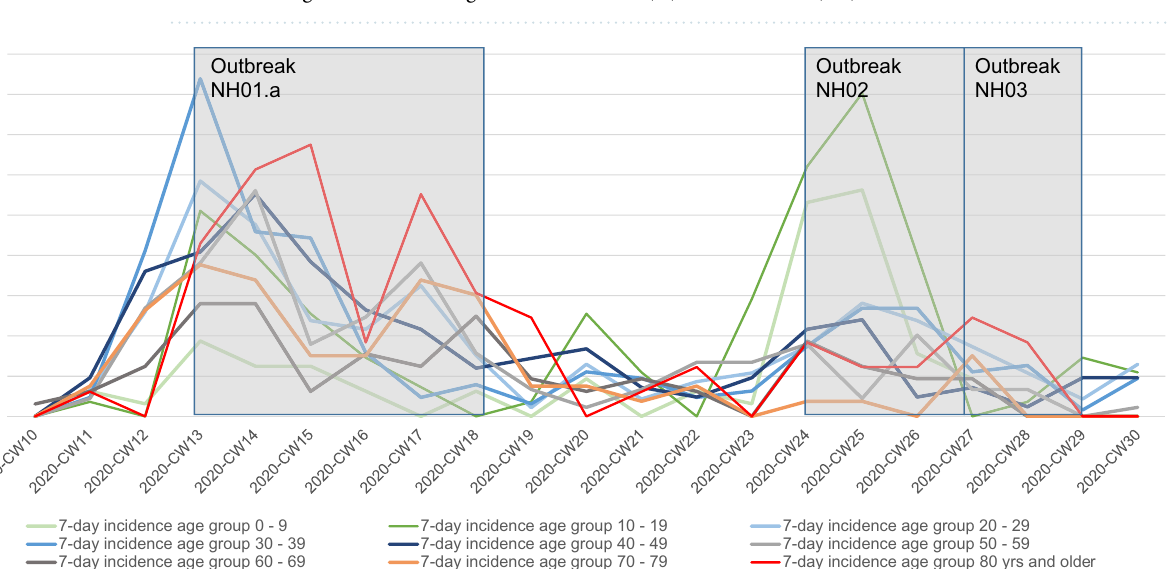
Figure 8. Significance of sex differences between the diseased and deceased residents and staff members of all affected nursing homes. Data are given in n-numbers (%) and risk ratios (RR) with 95% confidence interval.